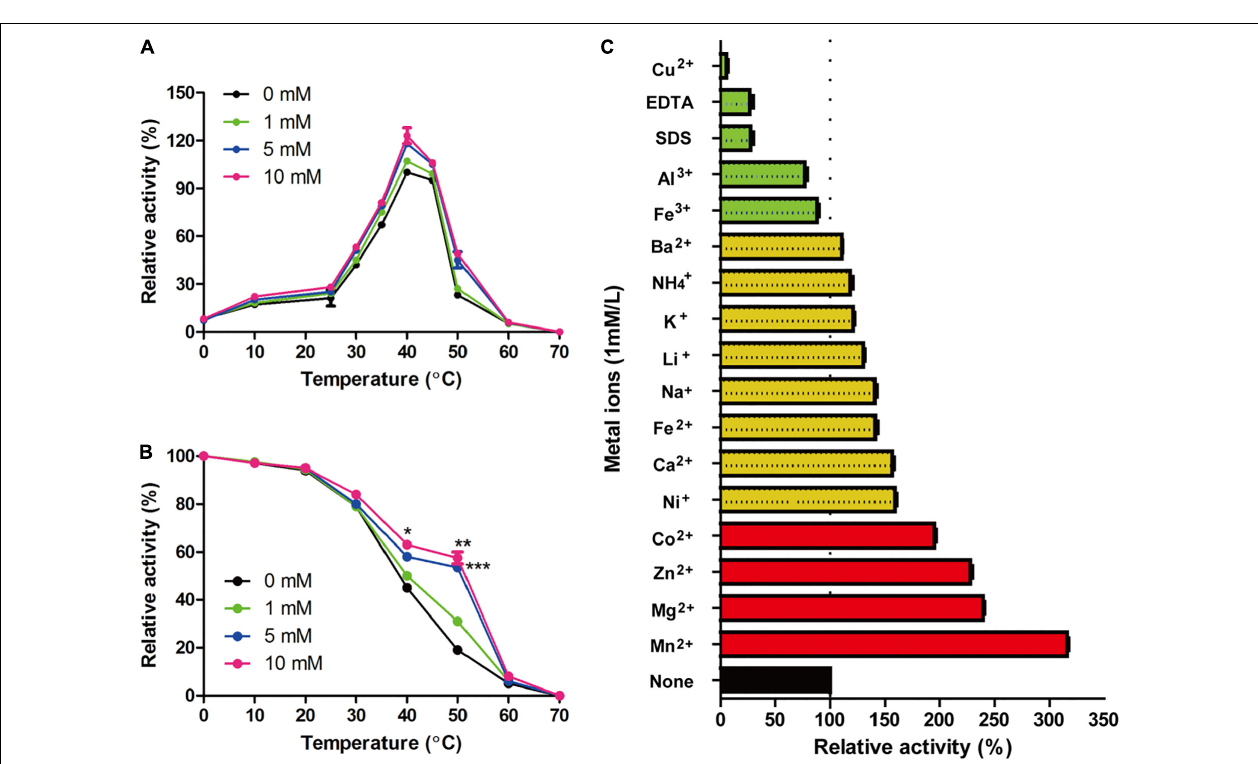
FIGURE 3 | Expression and purification of recombinant Gal42. (A) Time curve of Gal42 activity secreted into culture medium. (B) Sodium dodecyl sulfate–polyacrylamide gel electrophoresis (SDS-PAGE) analysis of the Gal42. The protein samples were separated by 10% SDS-PAGE gel and stained with Coomassie Blue G-250. Lane M, protein marker; Lane 1, the purified Gal42.